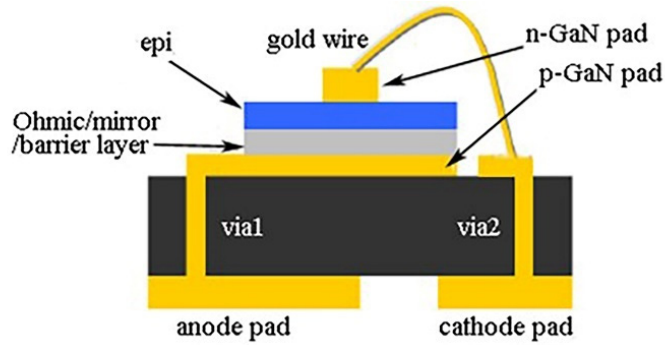
Figure 5. Schematic diagram of TFP LED structure [43].